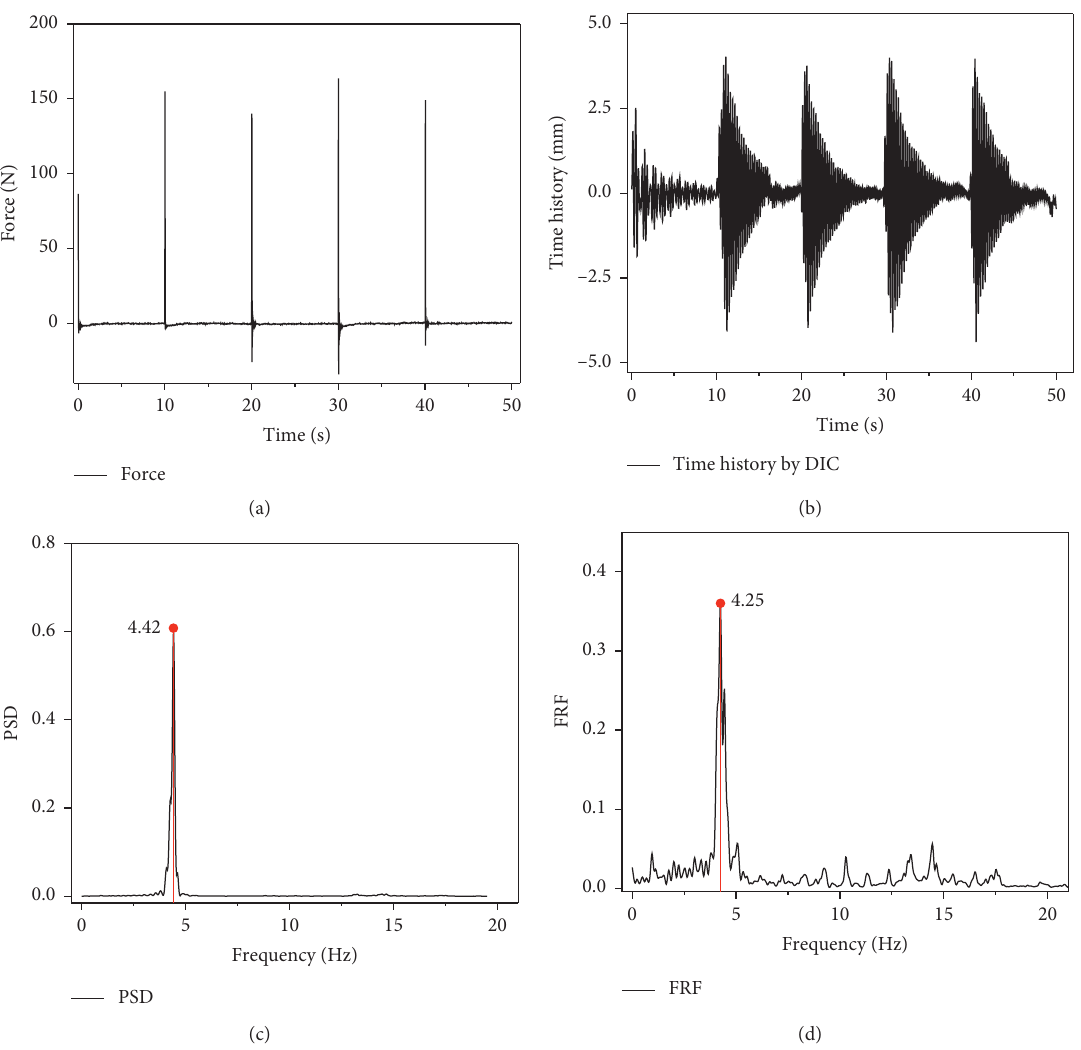
Figure 10: Comparisons of EMA and OMA. (a) The force signal. (b) Time history by DIC. (c) Frequency identified by PSD. (d) Frequency identified by